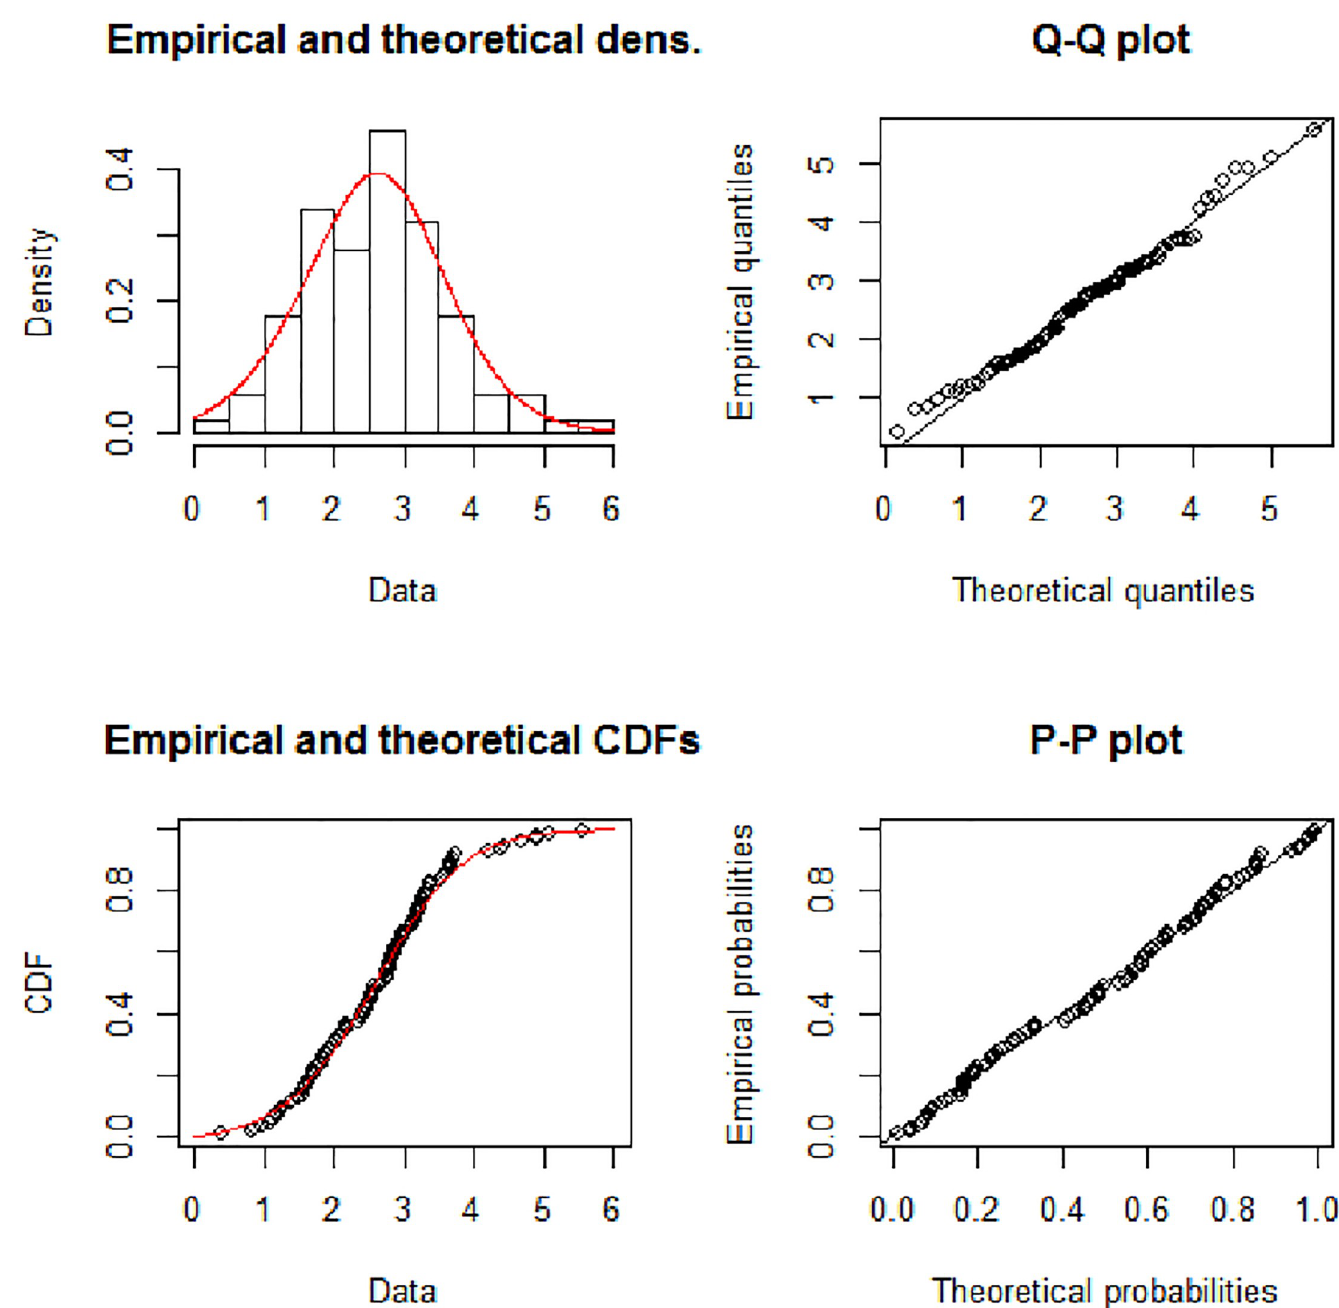
Fig 6. Theoretical and empirical Pdf and Cdf with Q-Q plot and P-P plot for LE for data set